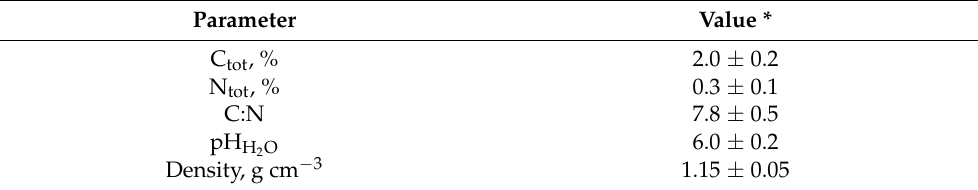
Table 1. Main soil properties.